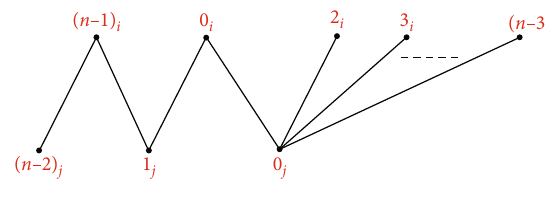
Figure 18: The labelling for ð C